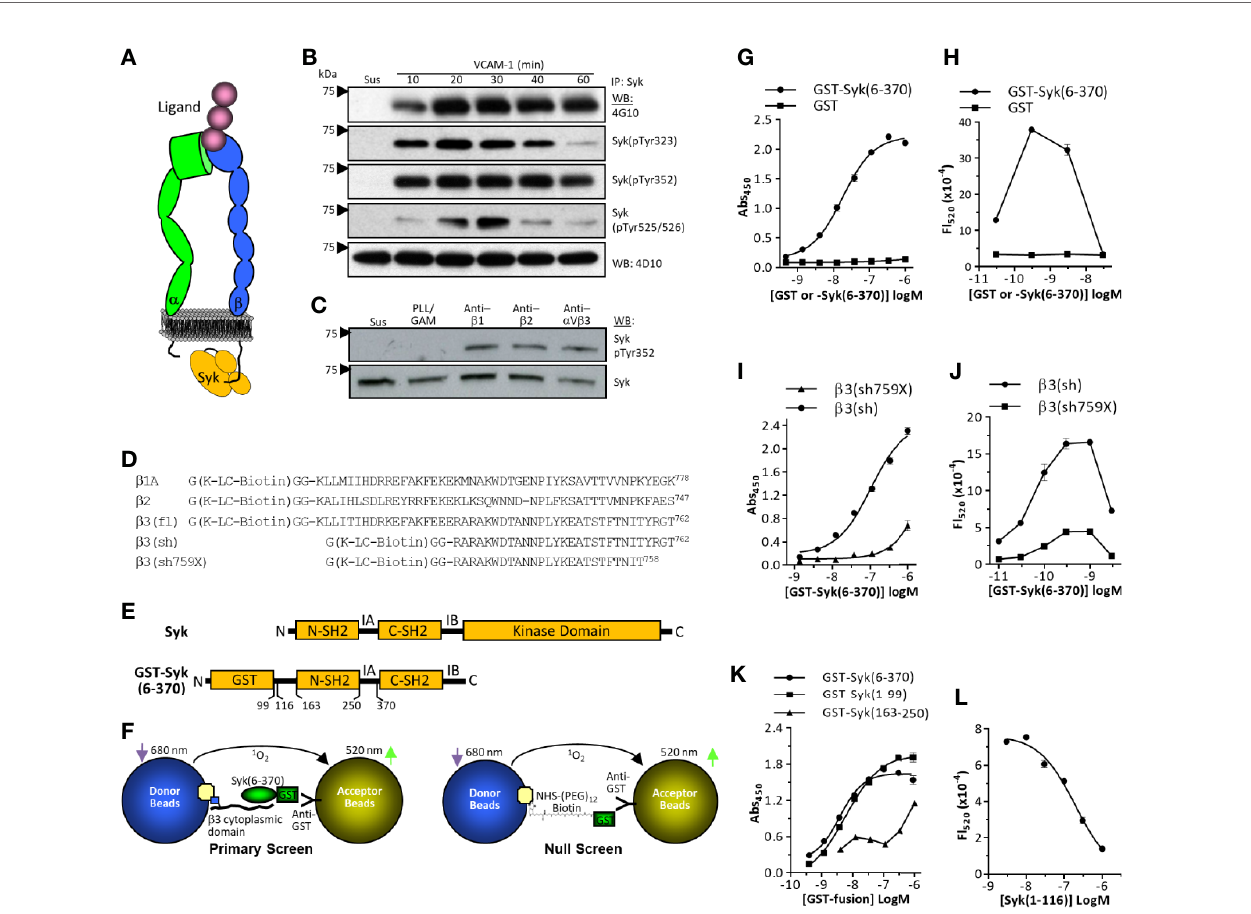
FIGURE 1 | Integrin signaling via Syk and cell-free screen development. (A) Schematic representation of a ligand-bound integrin with the short intracellular b – chain cytoplasmic domain directly interacting with the tandem SH2 domains of Syk. (B) Integrin a 4 b 1-dependent activation of Syk. THP-1 cells were either maintained in suspension (Sus) or plated on vascular cell adhesion molecule-1 (VCAM)-1 (immobilized at 3 ug/ml) for various time points. Cell lysates were immunoprecipitated with monoclonal antibody 4D10, then probed by western blot using indicated antibodies. One of three representative experiments is shown. (C) THP-1 cells were either maintained in suspension, plated on plastic immobilized poly-L-Lysine/GAM (as a non-speci fi c adhesion control), or GAM-captured anti- b 1 monoclonal antibody (mAb) TS2-16, anti- b 2 mAb 76C3, or anti- a V b 3 mAb LM609. One of four representative experiments is shown. (D) Synthetic peptides based on the cytoplasmic domain of the integrin b 1A, b 2, and b 3 subunits. Cytoplasmic domains were synthesized with an N-terminal region that included a biotin modi fi ed lysine residue (K-LC-biotin). Numbering is based on Uniprot canonical human sequences absent signal peptides (https://www.uniprot.org). (E) Schematic representation of Syk. SH2, src homology 2 domain; IA, Interdomain A; IB, Interdomain B. (F) Schematic representation of primary (left) and false-positive (right) AlphaScreen results. (G, I, K) ELISA-based b 3: GST-Syk binding assays performed as described in the Methods . Data represent mean ± SEM from triplicate determinations; one of